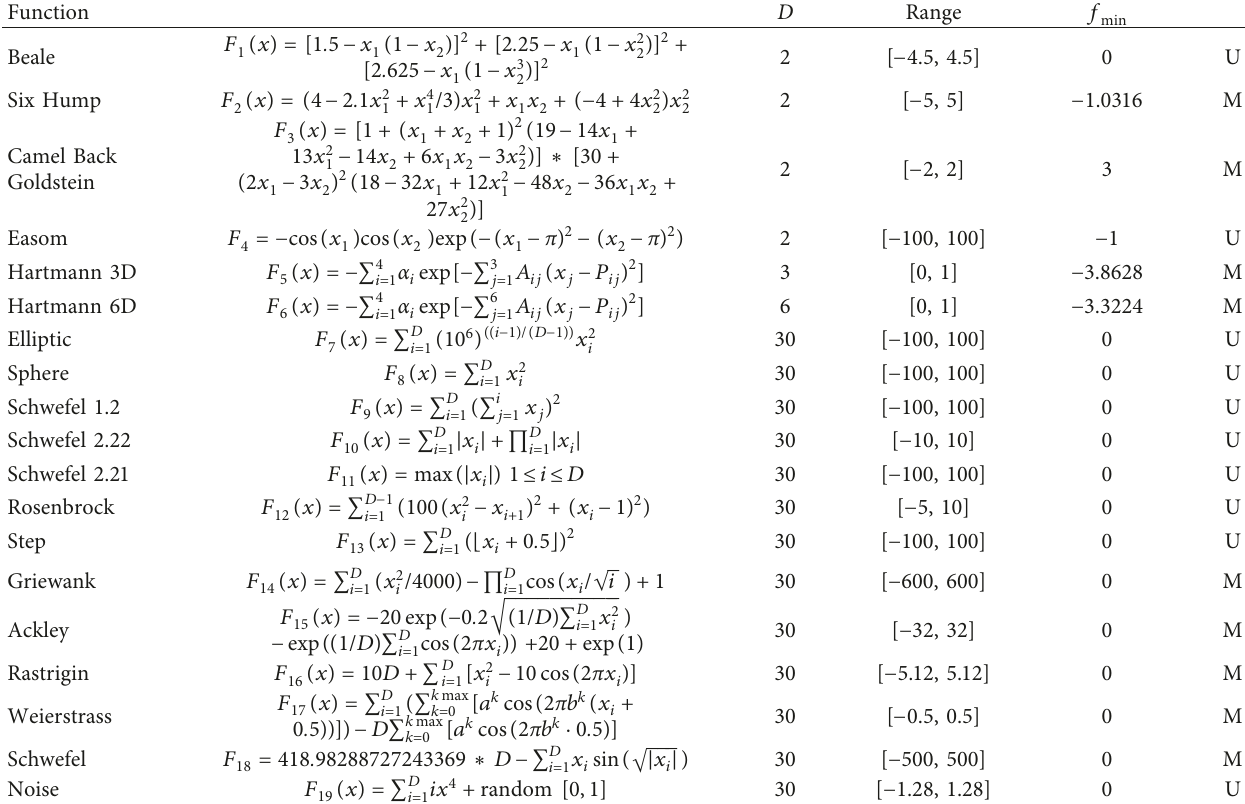
Table 3: Lattice parameters, volume, density, and crystallite size derived using Scherre’s equation.